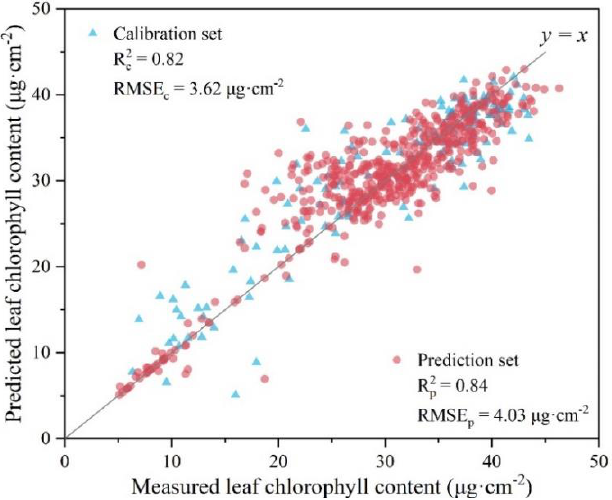
Figure 2. The prediction results of leaf chlorophyll content. The subscripts c and p represented the calibration set and prediction dataset. The results were accomplished by a support vector machine (SVM) regression model developed from multi − temporal spectral reflectance dataset (Experiments 1 and 2) with adding an external dataset from Experiment 3 using transfer component analysis